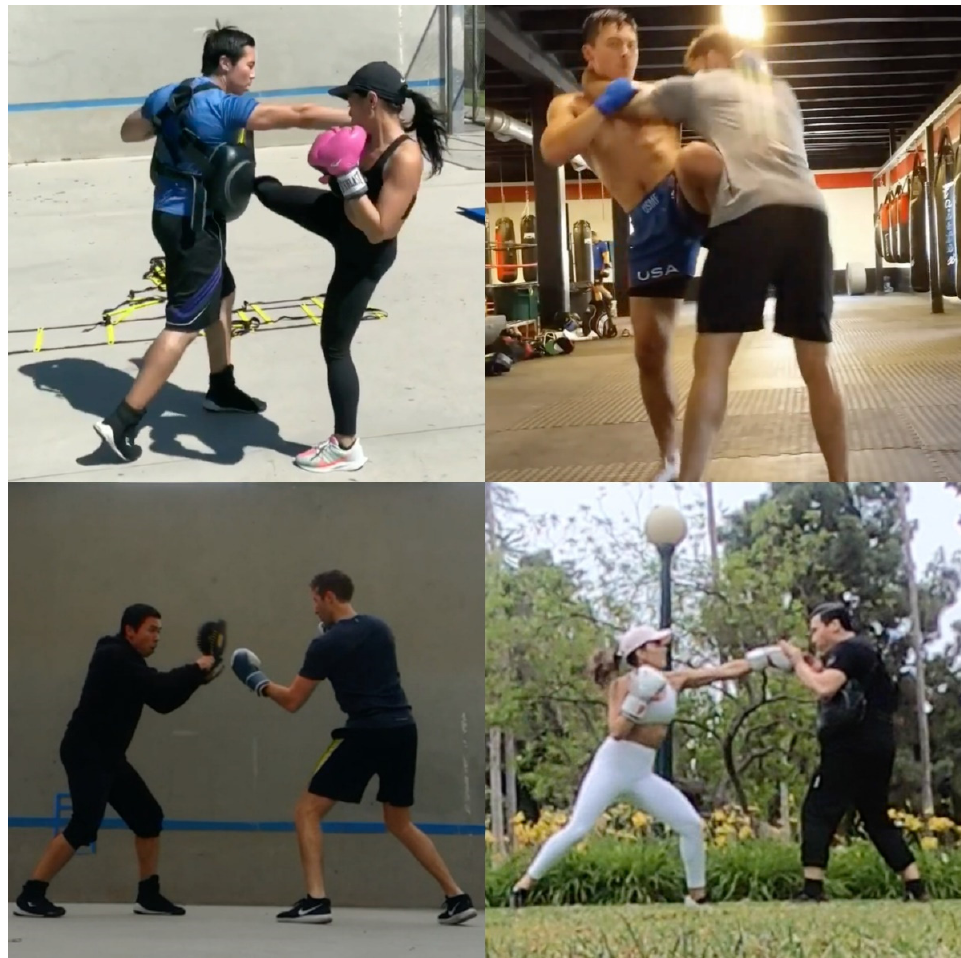
Figure 3. Muay Thai can contribute to engagement or flow experience. Whether shadowboxing alone or engaging in focused work with a partner, it is easy to become completely absorbed in the activity. One of the greatest benefits of gaining skill in a technical craft like martial arts is that the skill becomes a conduit for flow experience, an important component of psychological well-being. Developing social flow with others may also contribute to social relationships, another important component of psychological well-being. For video demonstrations of shadowboxing and interactive mitt work, please see the martial arts playlists on my YouTube channel: https://www.youtube.com/c/DrAdamMCroom (accessed on 25 April 2022). Muay Thai can therefore contribute to positive social relationships in several ways.